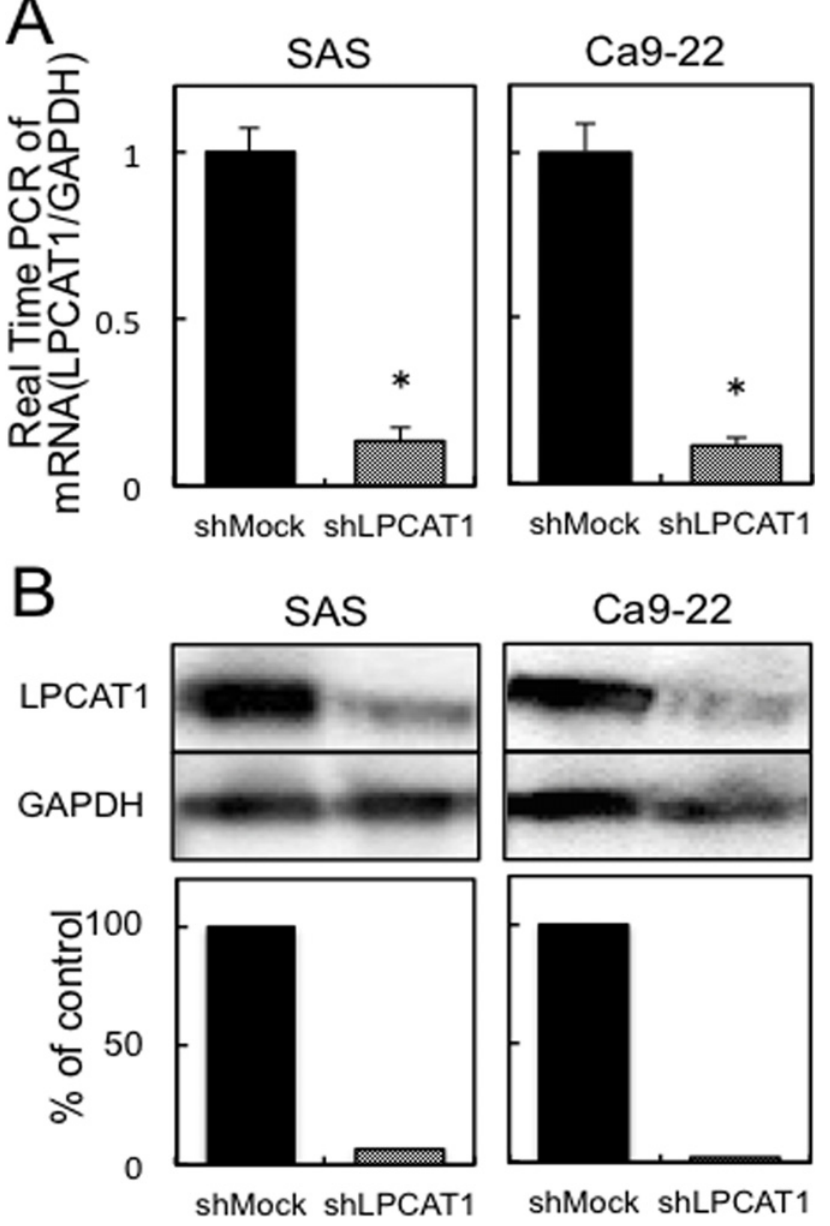
Fig 2. Establishment of shLPCAT1-transfected cells. ( A ) Expression of LPCAT1 mRNA in shMock- and shLPCAT1-transfected cells (SAS- and Ca9 – 22-derived transfectants). LPCAT1 mRNA expression in shLPCAT1-transfected cells is significantly ( * p < 0.05, Mann-Whitney U test) lower than in the shMock- transfected cells. ( B ) Immunoblot analysis of LPCAT1 protein in shMock- and shLPCAT1-transfected cells (SAS- and Ca9 – 22-derived transfectants). The LPCAT1 protein expression in shLPCAT1-transfected cells is decreased markedly compared with the shMock-transfected cells.